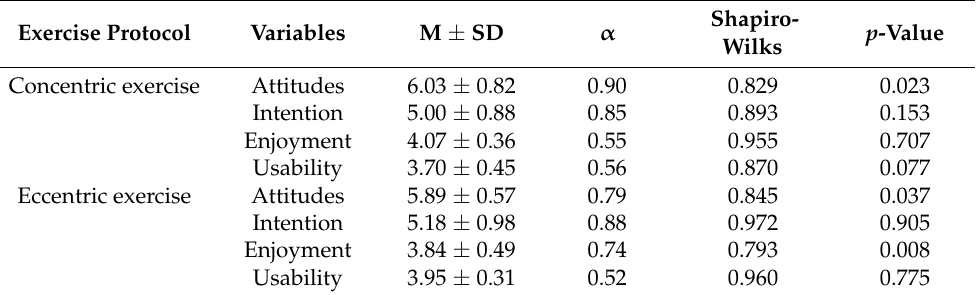
Table 1. Descriptive statistics, reliability index, and Shapiro-Wilks test for checking normality in both exercise protocols (concentric and eccentric).